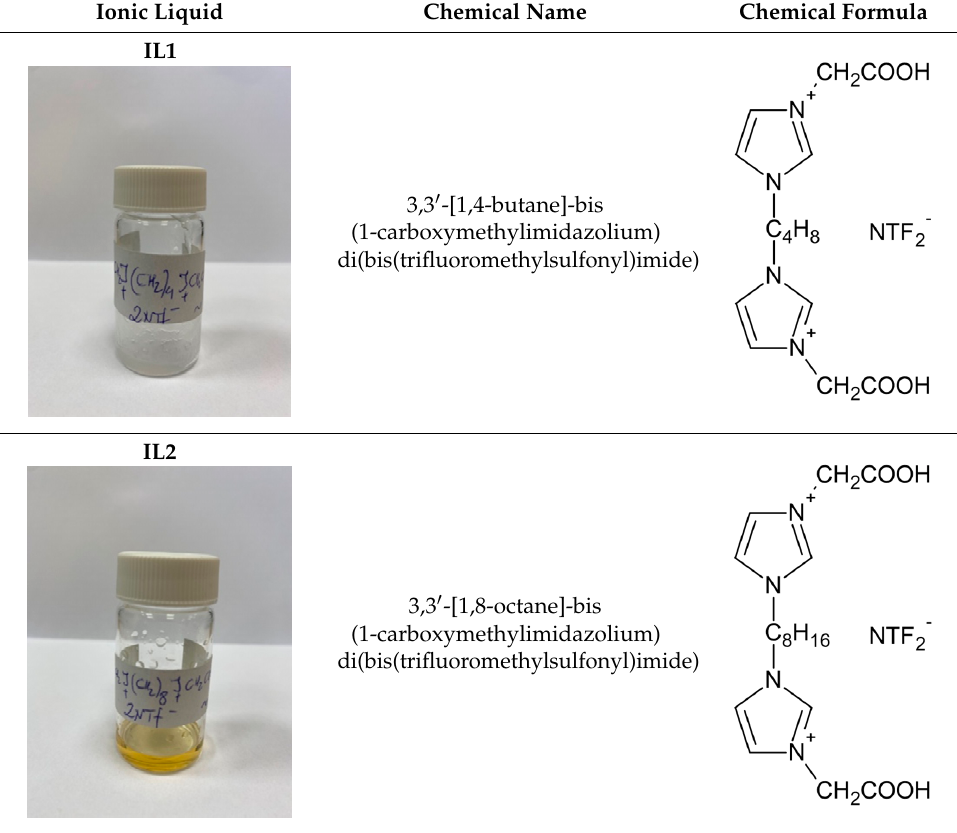
Table 3. Synthesized dimeric imidazolium ionic liquids.